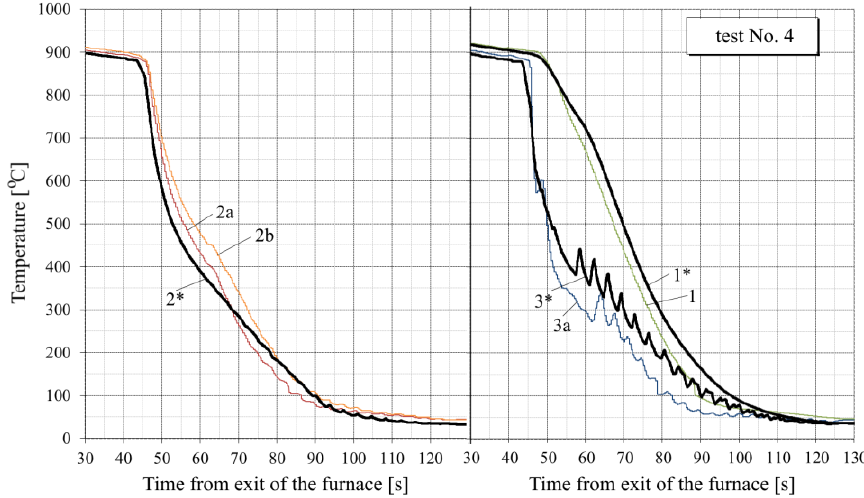
Figure A3. Graphs of cooling in test No. 4. The notations are the same as in Figure A1.